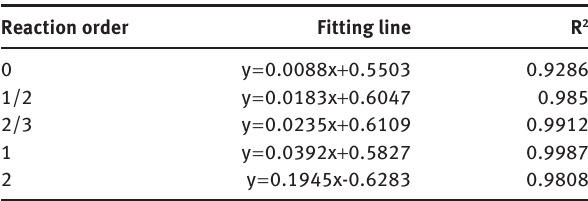
Table 7: The relationship between mechanism function and time at 550 ° C.